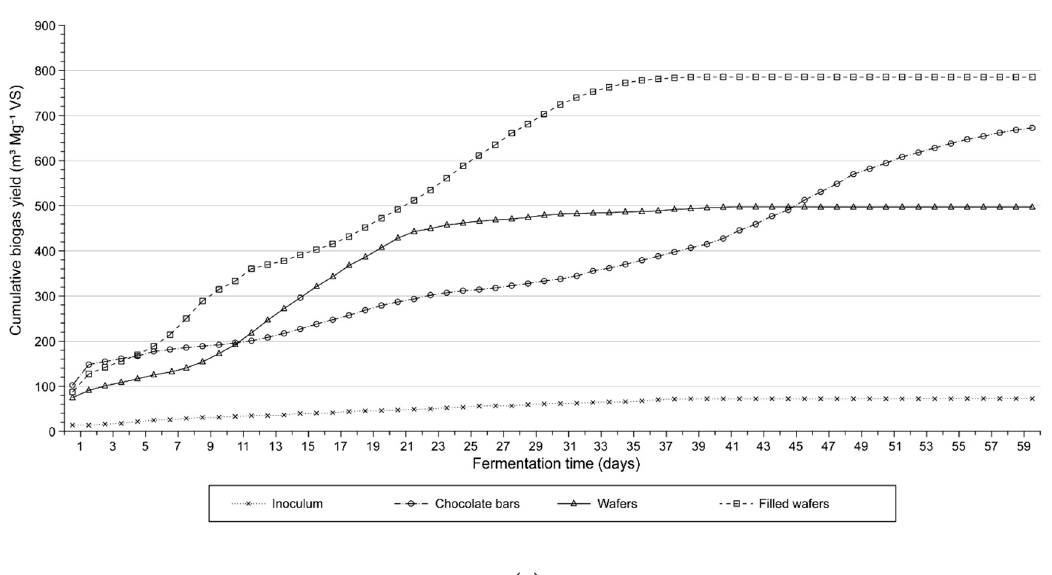
Figure 2. Variation in pH and VFA/TA during anaerobic digestion process of CB, W, and FW.